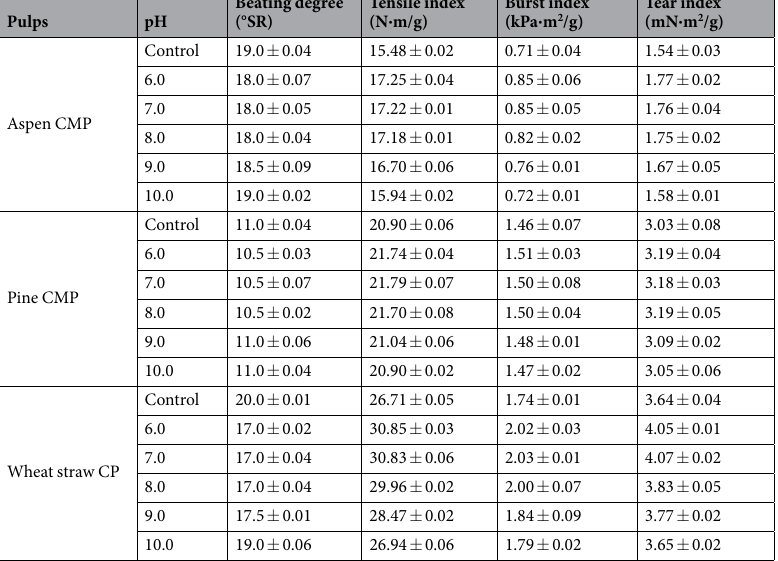
Table 2. Effect of different pH during enzyme treatment on pulp properties. * Enzyme dosage: 0.2 IU/g for wheat straw pulp, and 0.6 IU/g for hardwood pulp and softwood pulp, based on CMCase activity and oven dry pulp weight. ** Other conditions of enzyme treatment: 55 °C, 10% pulp consistency and treatment time 2